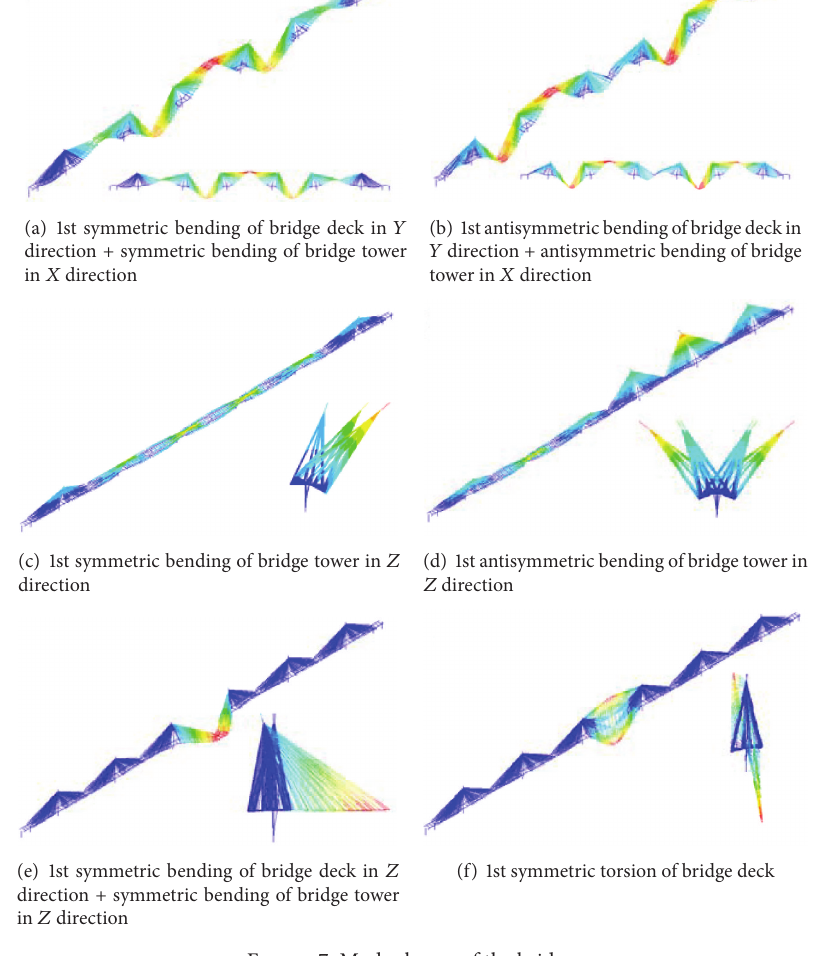
Figure 7: Mode shapes of the